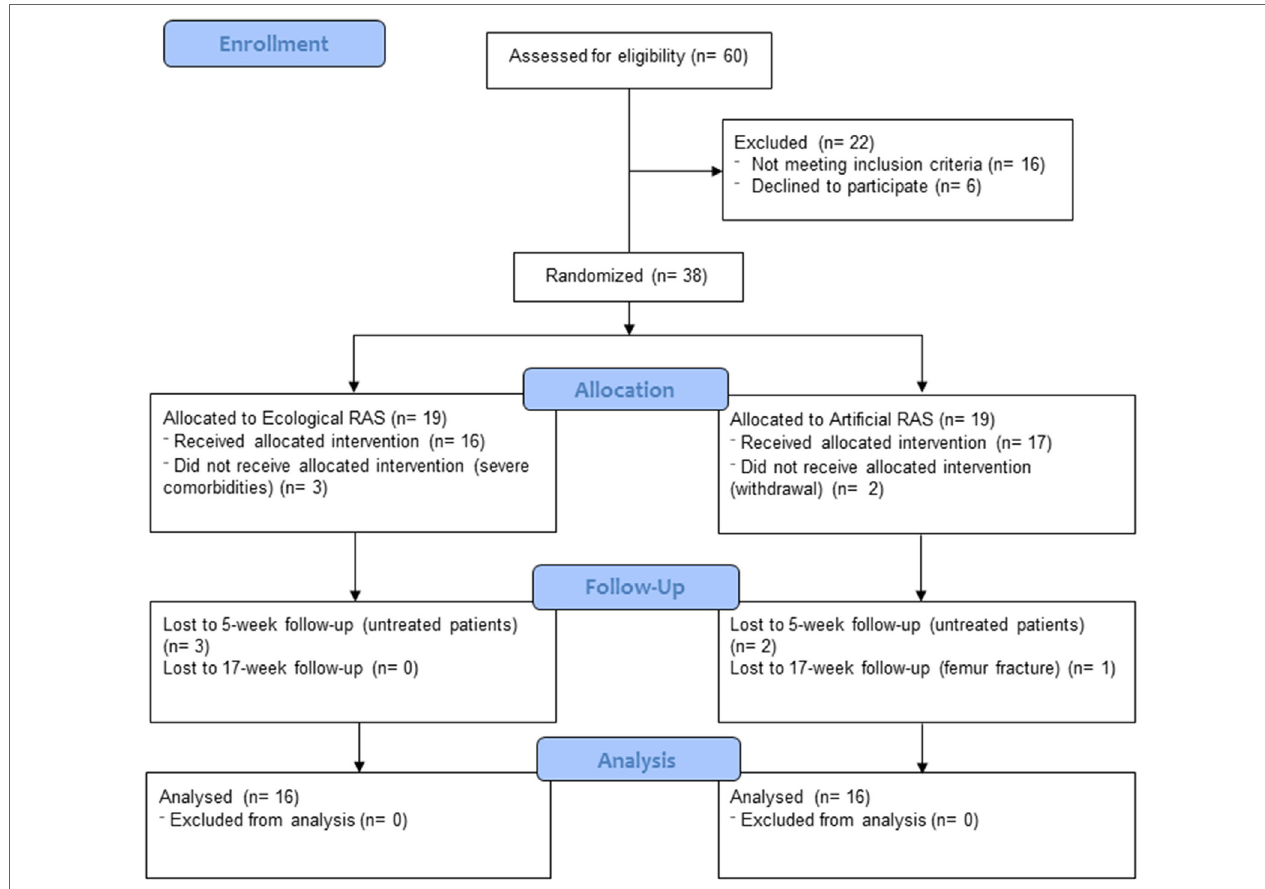
FiGUrE 1 | Participant flow